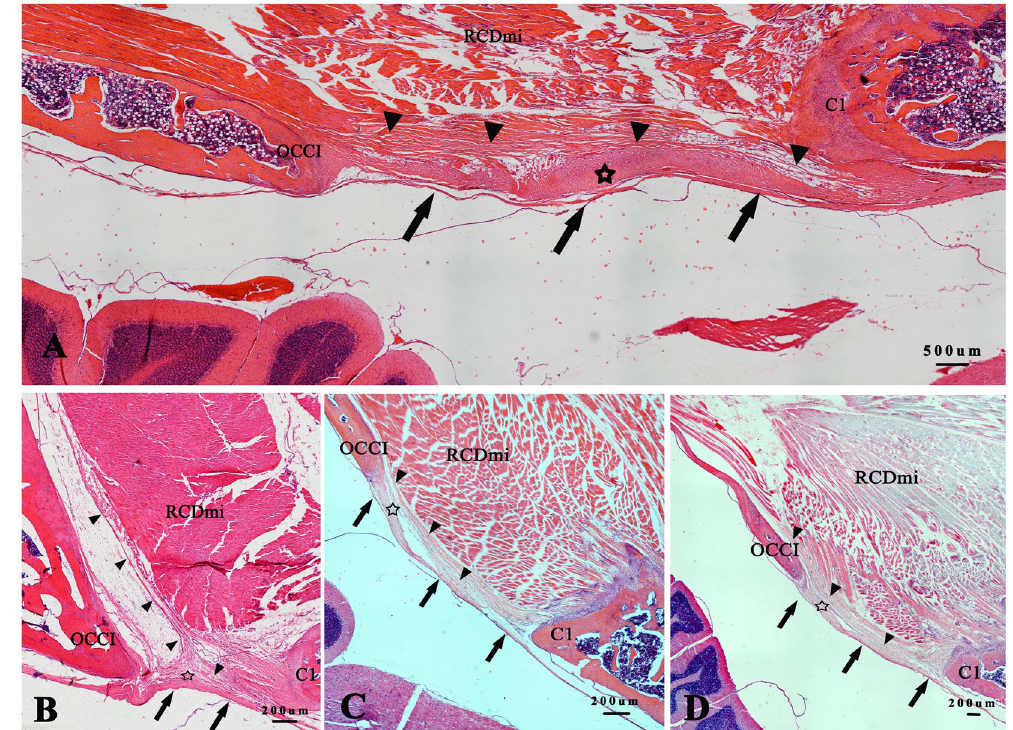
Figure 7. HE stained slides showing the dense fibrous connections between the RCDmi and the spinal dura mater. The dense fibrous bundles from the ventral part of the RCDmi ( ▲ ) tightly connected with the PAO membrane in ventral ( ☆ ) or passed through the PAO membrane and then fused with the spinal dura mater ( ↑ ) in Oryctolaguscuniculus ( A ), Feliscatus ( B ), Ratusnorvegicus ( C ) and Caviaporcellus ( D ). The PAO membrane fused with the spinal dura mater tightly in all the